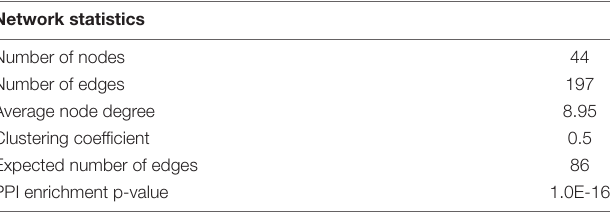
TABLE 4 | Network Statistics of metabolism-related proteins.